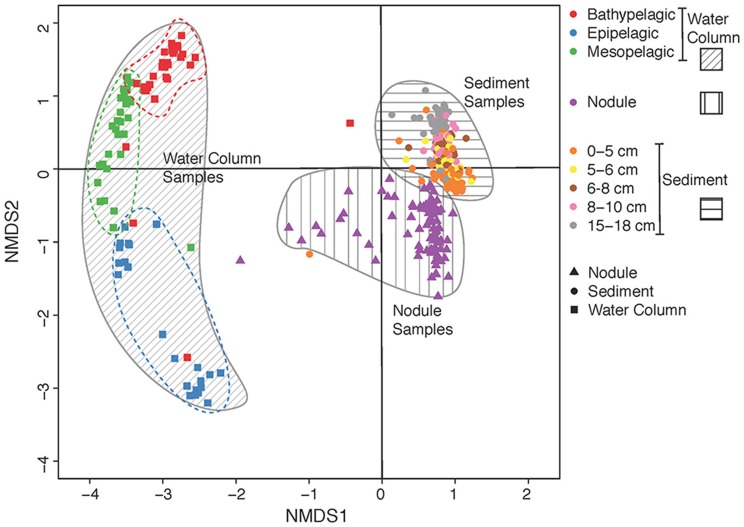
Non-metric multidimensional scaling (nMDS) plot of microbial community dissimilarity (beta diversity) calculated from Bray-Curtis distances. Gray areas denote visual clustering of samples into different habitat (water column, sediment and nodules) and dashed lines denote visual clustering of vertical segments within the water column (i.e., the epipelagic, mesopelagic, and bathypelagic zones).